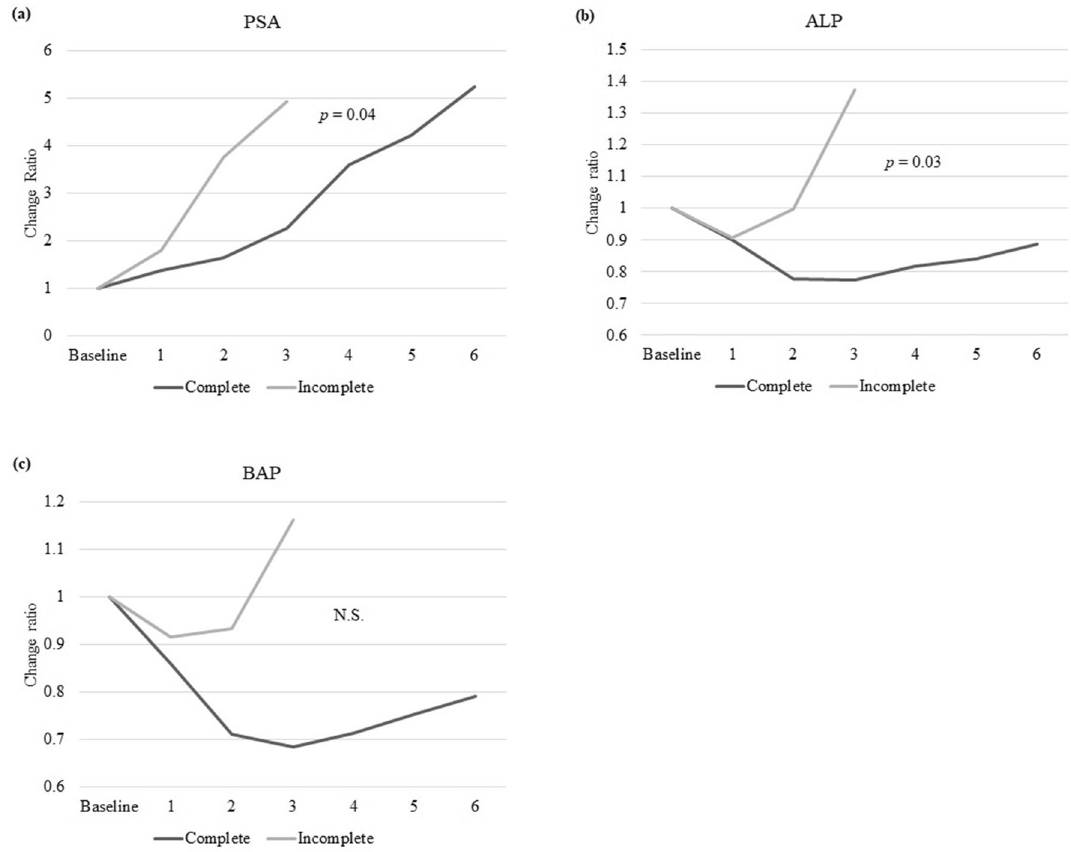
Figure 3. Changes in biomarkers during Ra-223 treatment. ( a ) PSA, ( b ) ALP and ( c ) BAP. p -values in change ratios from baseline between the complete and incomplete groups after the third administration. Mean PSA levels tended to increase throughout the entire Ra-223 treatment period in both the complete and the incomplete groups, however significant difference was seen between the two groups ( p = 0.04). Mean ALP and BAP levels decreased after the third administration in the complete group, compared with baseline (mean change ratios 0.77 and 0.68, respectively), while levels in the incomplete group increased (mean change ratios 1.38 and 1.16, respectively). Significant difference was seen in ALP levels ( p = 0.03), while was not seen in BAP levels ( p = 0.08) between the two groups. PSA; prostate specific antigen, ALP; alkaline phosphatase, BAP; bone- specific alkaline phosphatase, N.S.; not